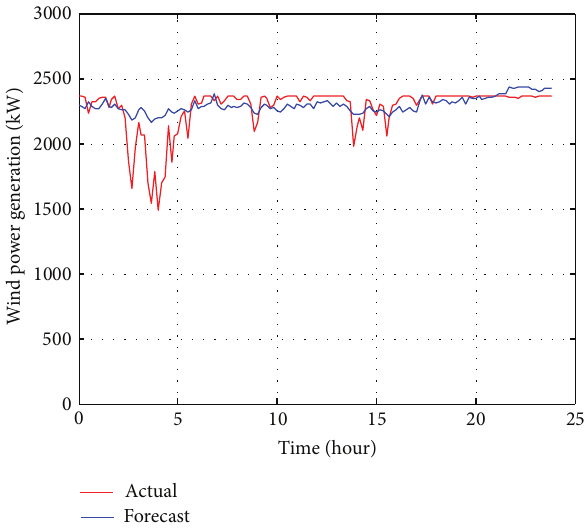
Figure 8: Test results with the RBF neural network based method for typical summer day.